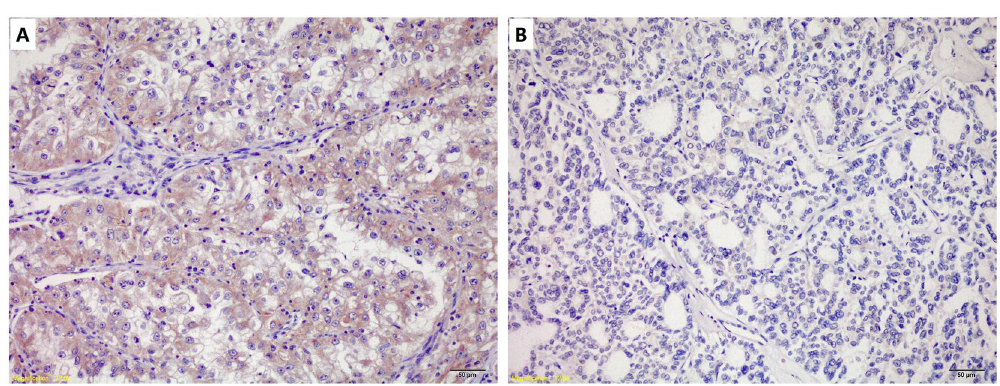
Figure 2. Immunohistochemical analysis of programmed death receptor 1 (PD-L1) expression in Xp11.2 RCC. ( A,B ) Tumor sections with ( A ) positive, and ( B ) negative PD-L1 expression (magnification, × 200). Note that PD-L1 protein is expressed on the cell membrane as well as the in the cytoplasm of tumor